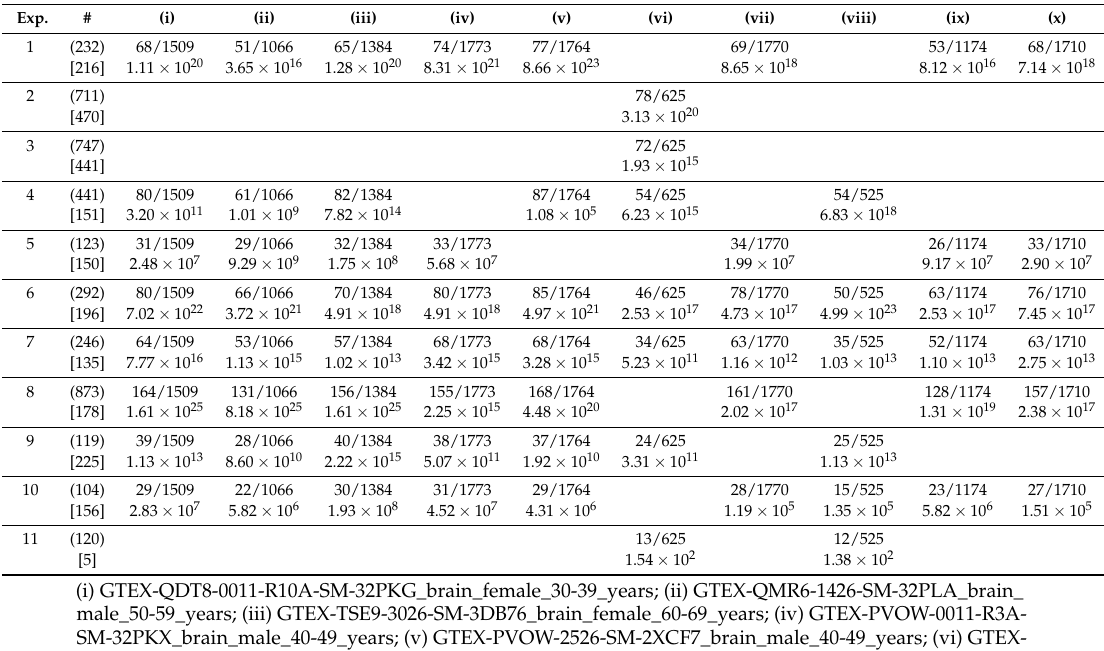
Table 7. In each of the 11 experiments, 20 top-ranked significant tissues whose set of upregulated genes significantly overlapped with the set of genes selected for each experiment were identified.